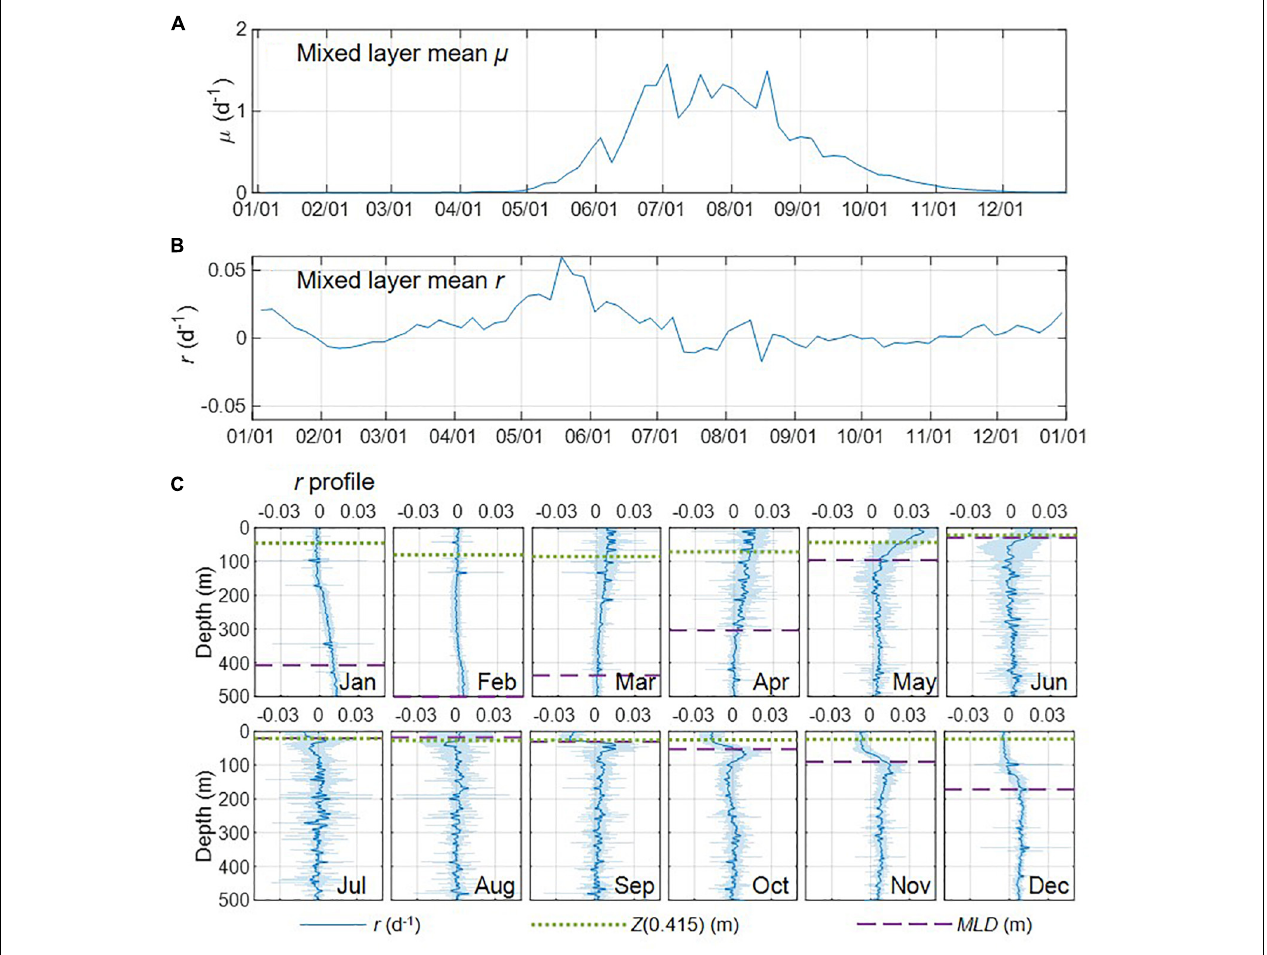
FIGURE 8 | (A,B) Seasonal climatologies of mixed layer mean µ , and r for region D1. (C) Monthly climatologies of specific net phytoplankton accumulation rates ( r ) profiles derived from Argo profiling floats (standard deviation indicated with the shading) in. The green dotted line and purple dash line indicated isolume depth Z(0.415) and mixed layer depth ( MLD ),